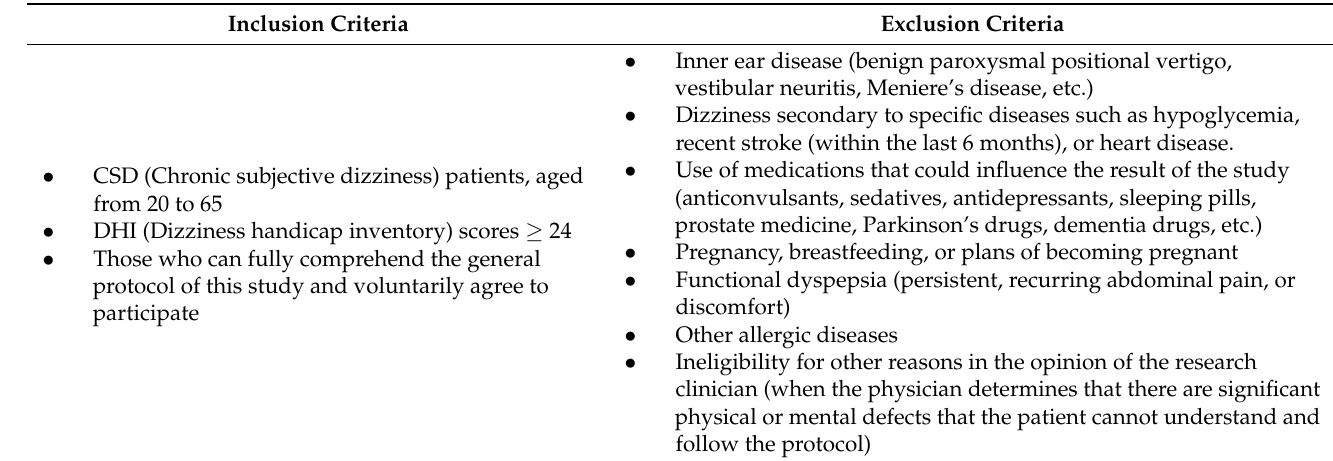
Table 1. Inclusion and exclusion criteria.